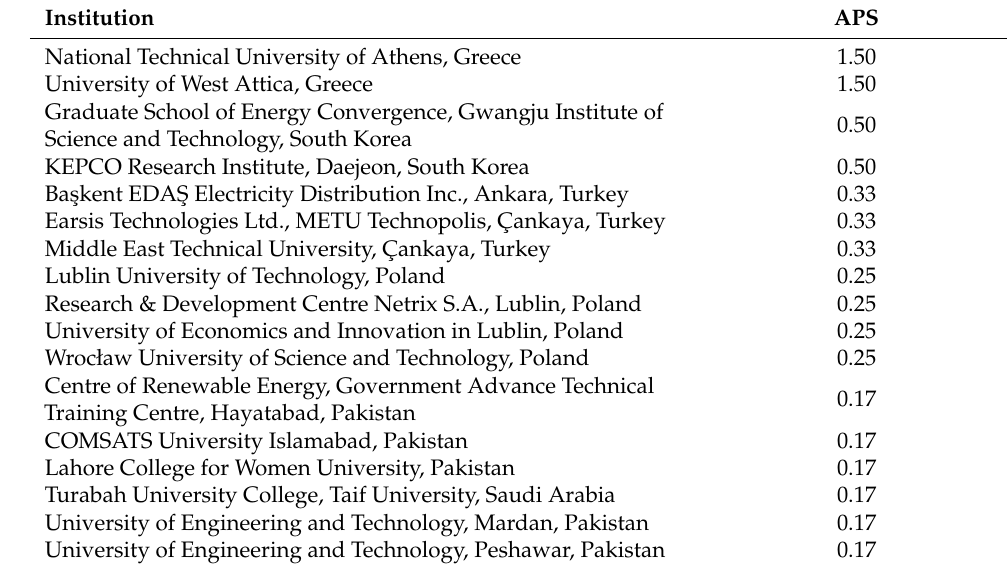
Table 2. Most productive institutions sorted by